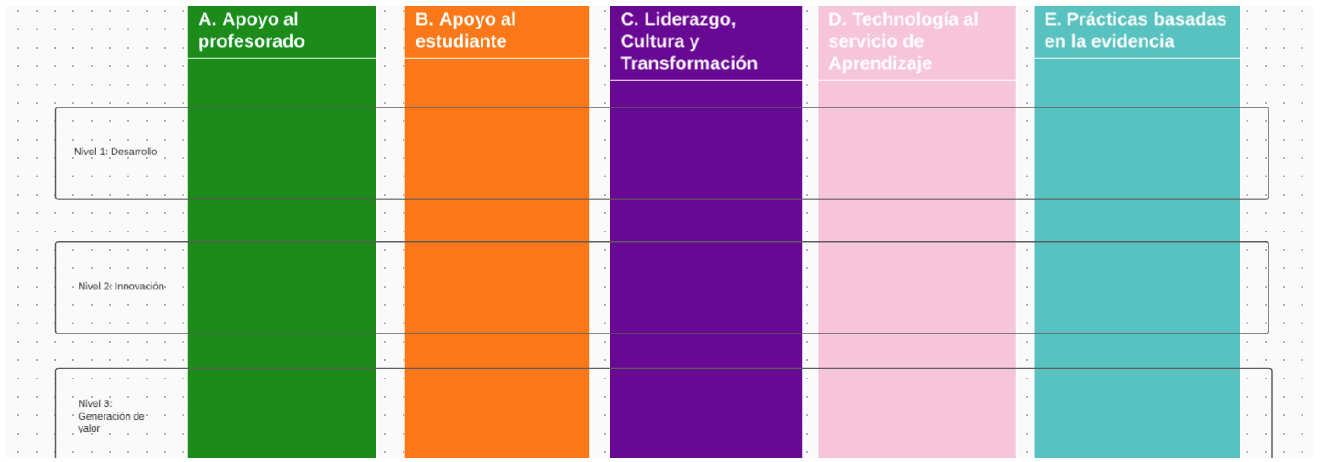
Figure A2. Poster used for the second activity of the first phase in the workshop with Administrators, Managers, and Teaching/Academic staff.